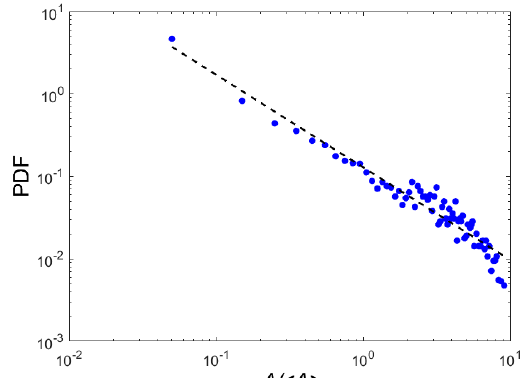
Figure 6. Example of a PDF calculated for one of the specimens using data from all extensometers ( ε > ε cr ). The dashed line indicates the slope β = 1.04 ± 0.05.